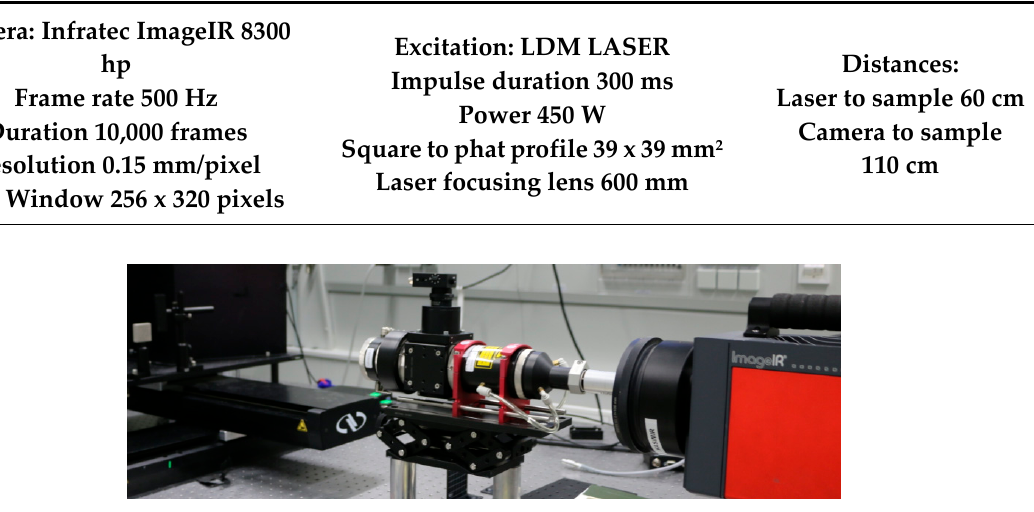
Figure 2. Setup for stepped thermography using a widened laser